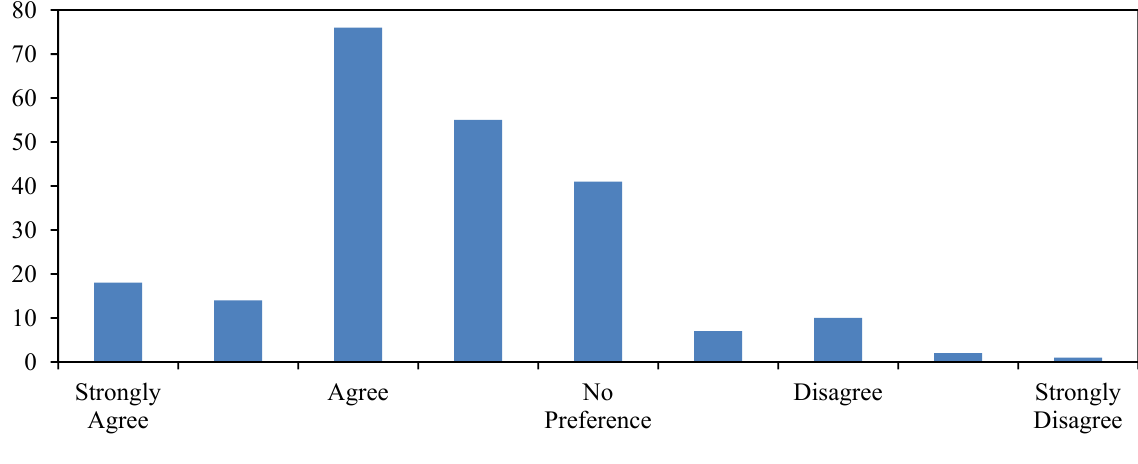
Figure 10. Graph of responses to the statement “I would trust computer analysis of data if data sets used for analysis were occasionally (at random time intervals) sent back with the analysis results for